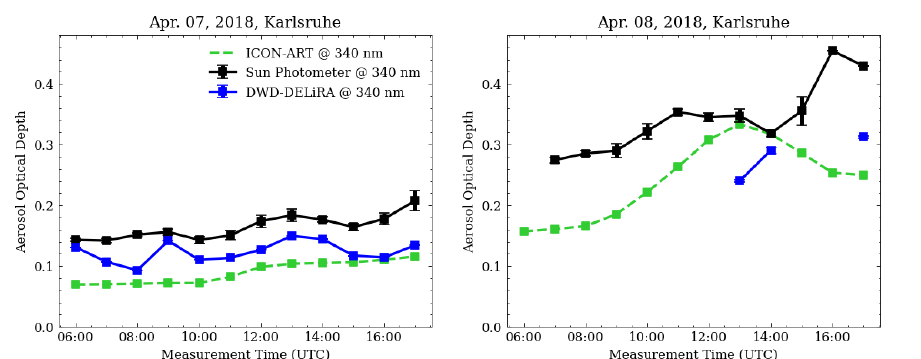
Figure 7. AOD from the LiDARs (blue circles) and sun photometer (black squares) on 7 and 8 April for a 1 h temporal resolution. ICON-ART results are shown for comparison (dashed green line) and are discussed in Section 3.3.